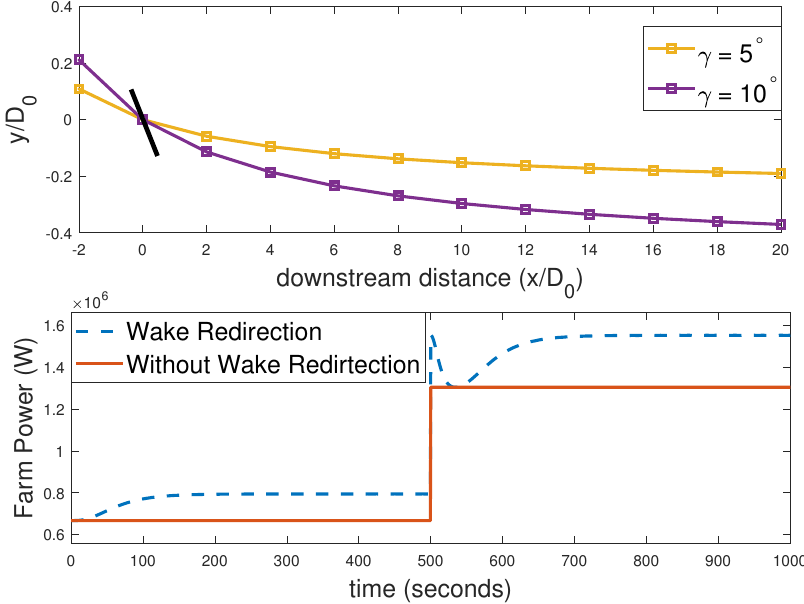
Figure 8. Wake center deflection and Wind farm power